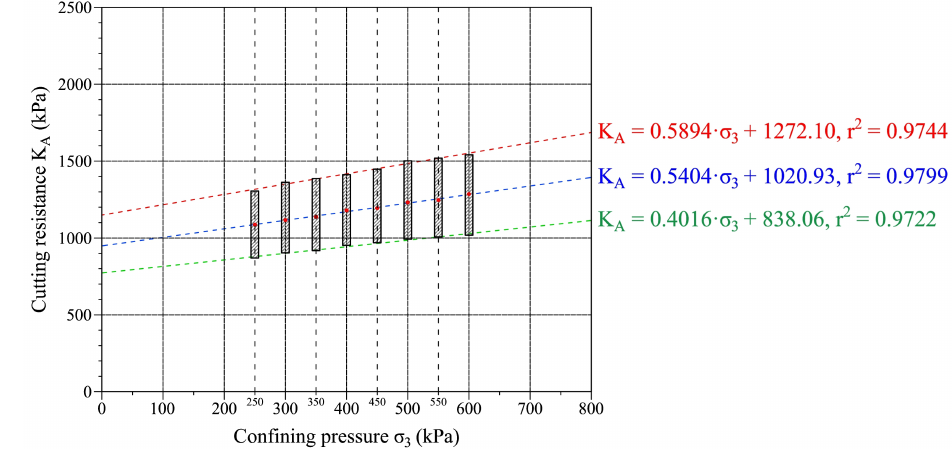
Figure 21. Linear approximation of the modified wedge test results. Table 4. Linear function parameters for approximation of the modified wedge test results.